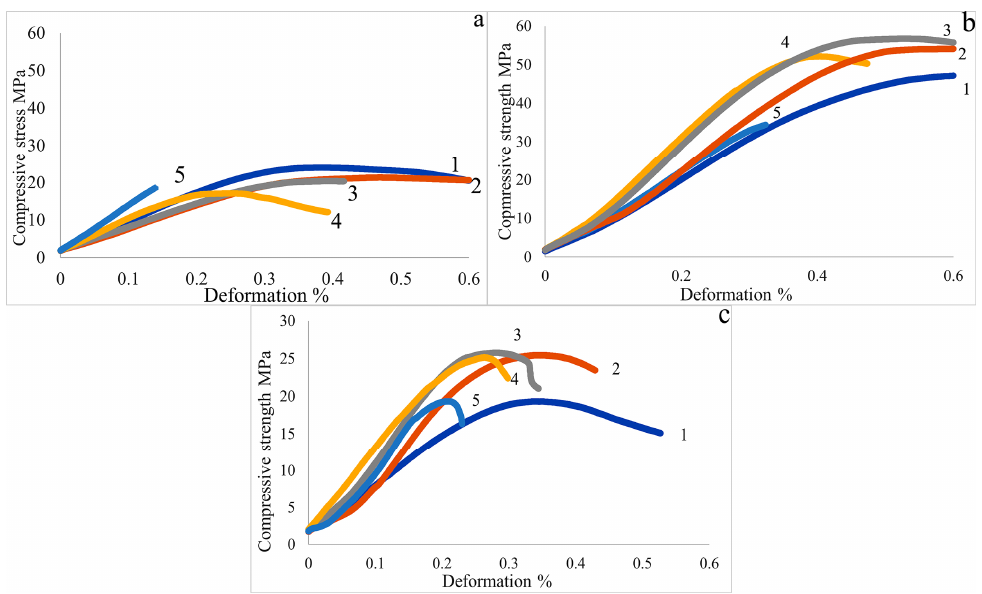
Figure 6. The compression test of PSU based composites filled with 30 (1), 40 (2), 50 (3), 60 (4) and 70 (5) wt.% of NG ( a ), AG ( b ) and EG ( c ).